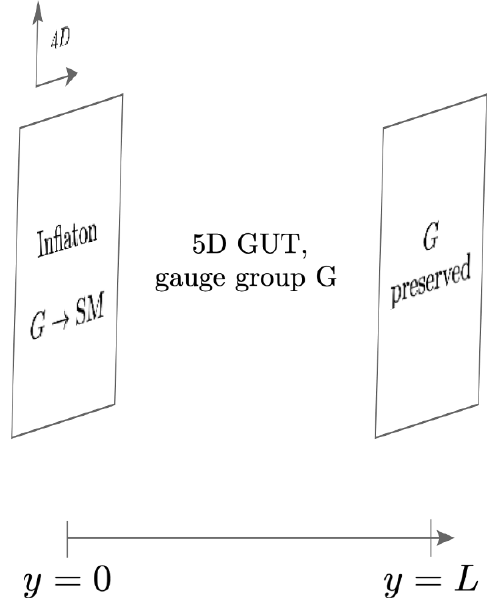
Figure 2 . 5D spacetime having two boundaries at y = 0 and y = L . (a) Dirichlet Boundary Conditions (BC’s) on the gauge bosons of GUT/SM achieves the breaking G ! SM on the left boundary, also housing the in(cid:13)aton (cid:30) ( x ). Neumann BC’s on all gauge bosons preserve G on the right